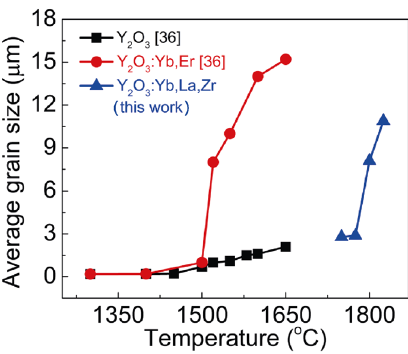
Fig. 13 Effect of the sintering temperature on the average grain size of Y 2 O 3 ceramics vacuum sintered for 10 h.